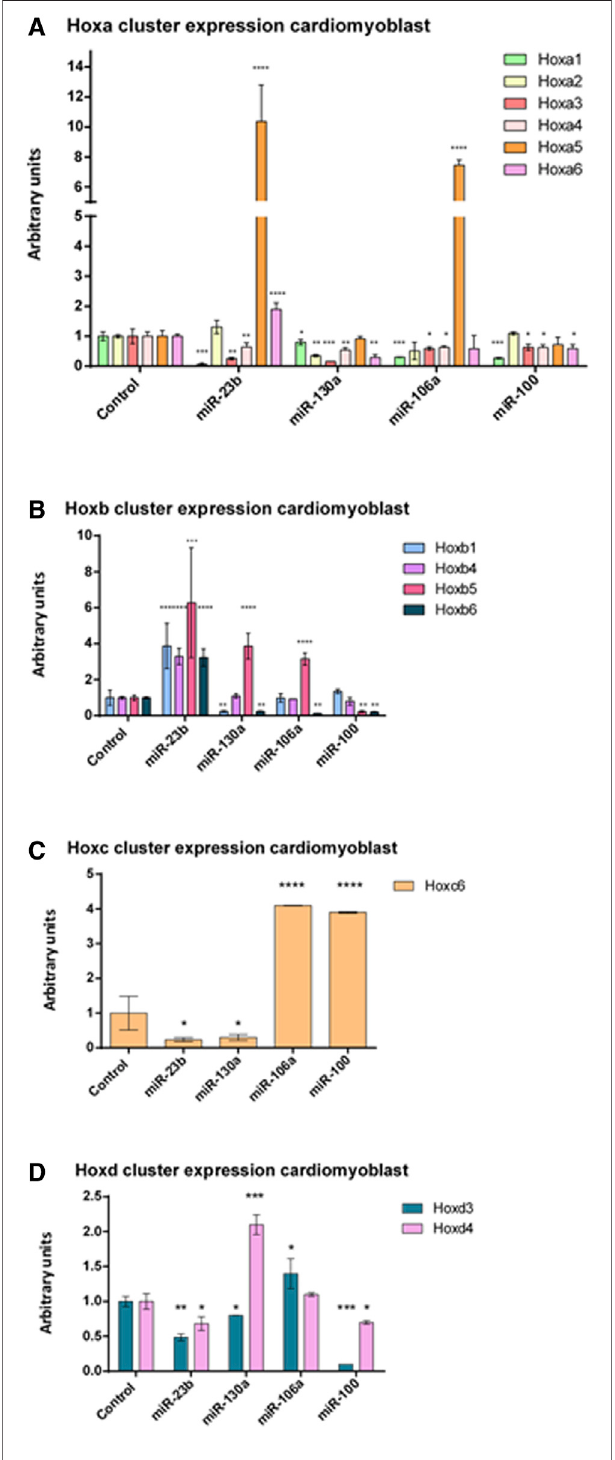
FIGURE 5 | qPCR analysis of Hoxa (A) , Hoxb (B) , Hoxc (C) , and Hoxd (D) clusters expression after miR-23b, miR-130a, miR-106a, and miR-100 gain-of-function assays in H9c2 cardiomyoblasts illustrating signi fi cant up- and downregulation of these Hox genes. Student ’ s t -test: * p < 0.05, ** p < 0.01, *** p < 0.005, **** p < 0.001.